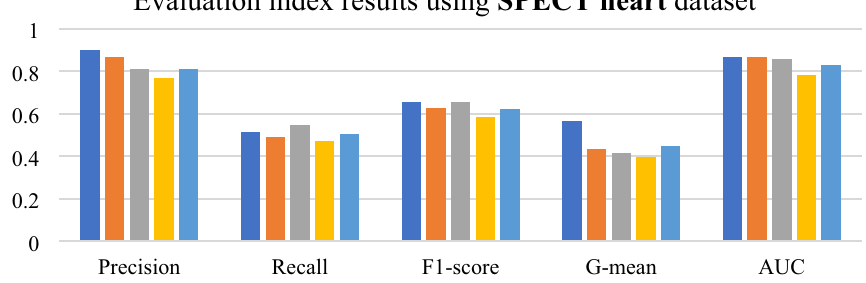
Evaluation index results using SPECT heart dataset